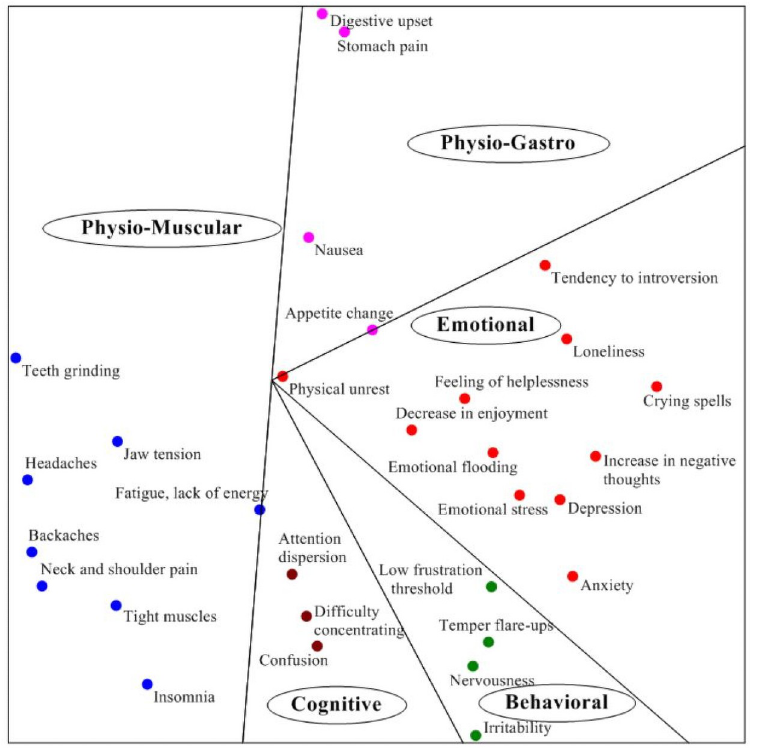
Fig 2. Map of smallest space analysis (SSA) of stress responses for study 2.